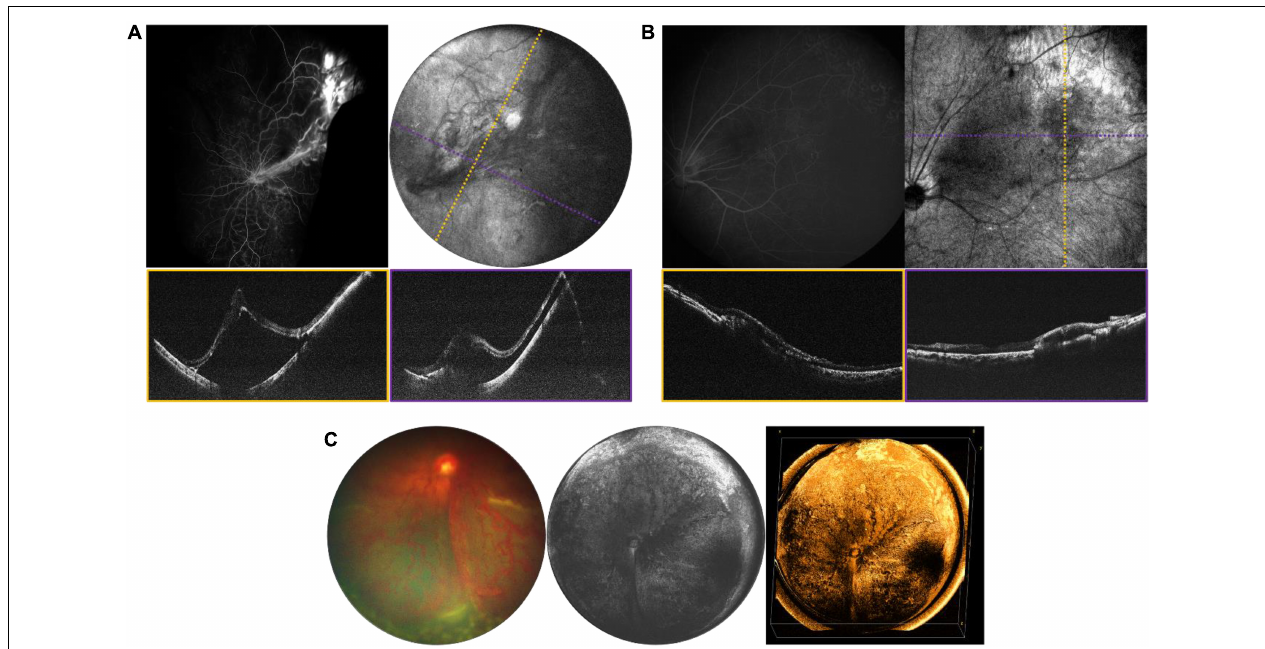
FIGURE 4 | Tractional and exudative retinal detachments. (A) ERD in a 15-year-old girl in the setting of a vasoproliferative lesion. (B) Chronic exudative retinopathy in a 16-year-old girl. For (A,B) , top left image is fluorescein angiography (FA), top right is the mean-intensity en face projection [105 ◦ FOV for panel (A) and 40 ◦ FOV for panel (B) ], with dotted lines indicating the locations of the color-coded B-scans shown below. (C) ERD in a 5-month-old patient with ROP. From left: fundus photograph, 105 ◦ FOV OCT en face, and three-dimensional rendering of the same OCT volume.